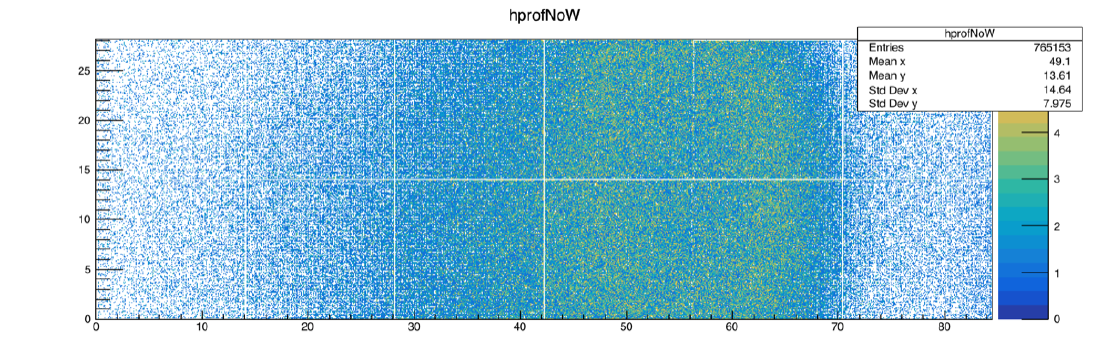
Figure 7. Timepix3 array showing the beam profile in the Data